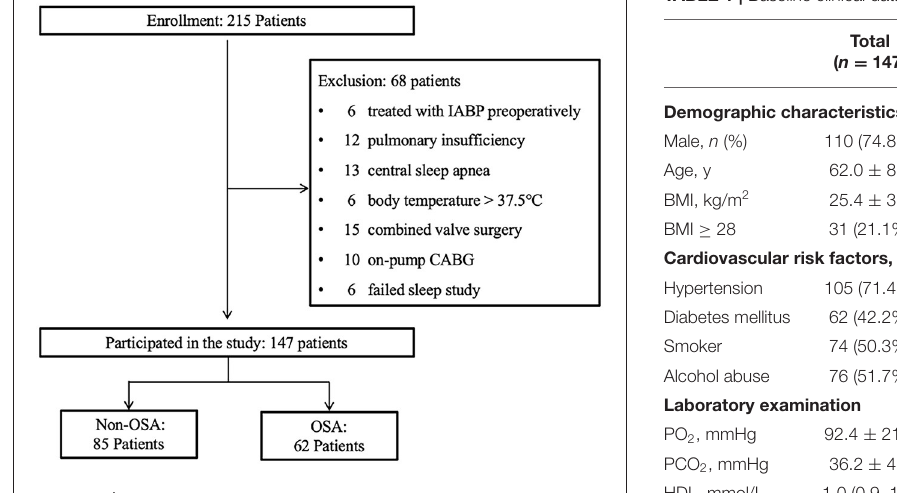
FIGURE 1 | Study design flowchart. IABP, intra-aortic ballon pump; CABG, coronary artery bypass grafting; OSA, obstructive sleep apnea.